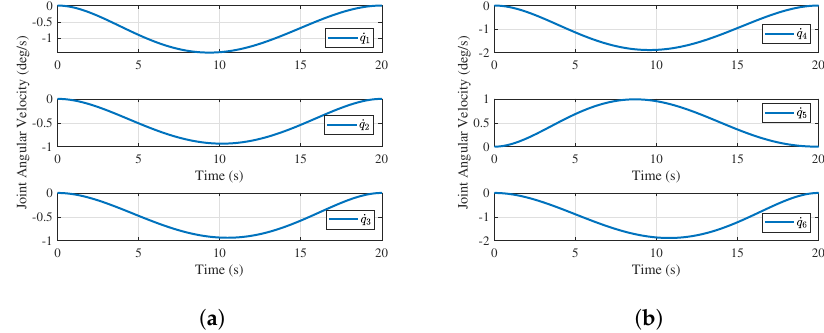
Figure 11. Velocity variation curves of i th joint, where ( a ) i = 1, 2, 3, and ( b ) i = 4, 5, 6.